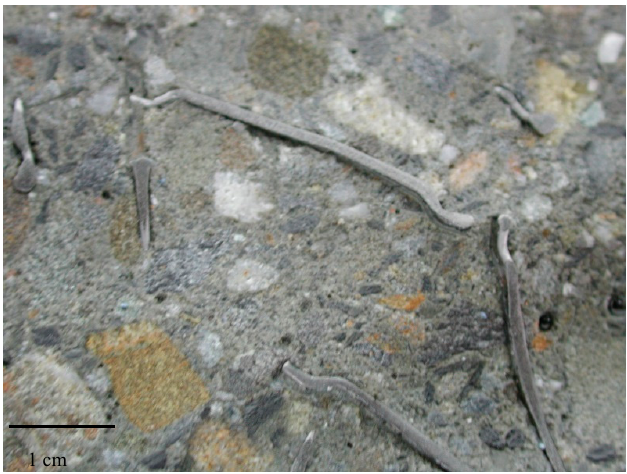
Figure 4. Typical abrasion site in steel fiber concrete abraded by friction abrasive action (w/cm = 0.36, ASTM C1138).